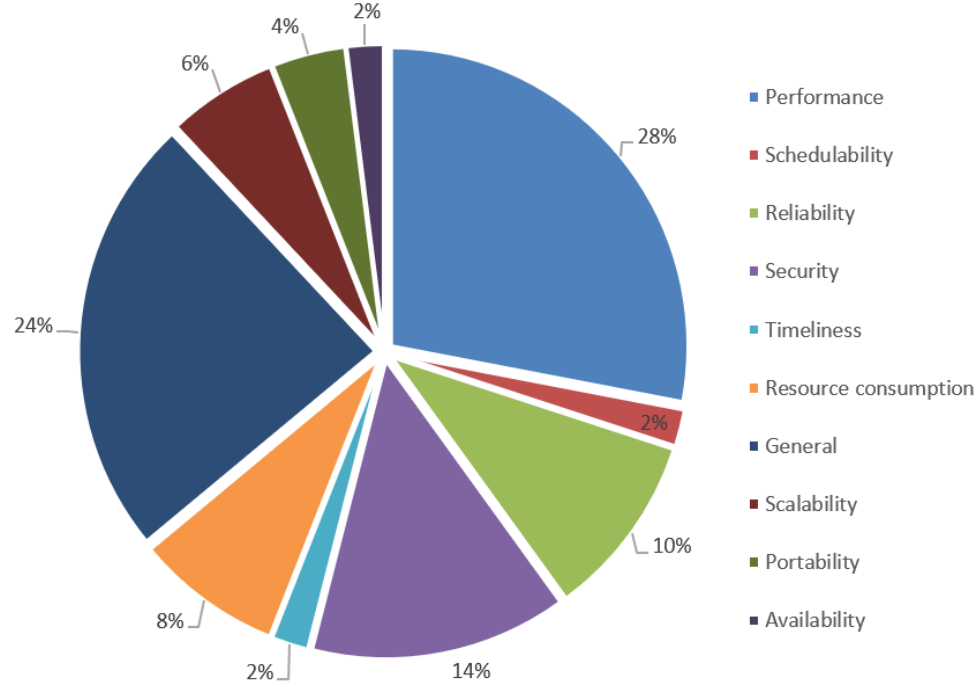
Figure 3. The percentages of the modeling languages for IoT that support nonfunctional proper- ties.